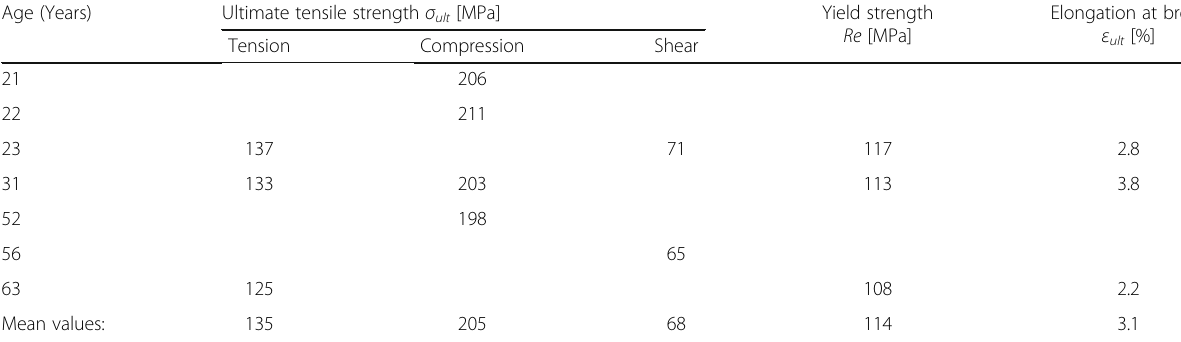
Table 2 Age-related strength properties of the cortical bone from (Reilly and Burstein 1975) Age (Years)